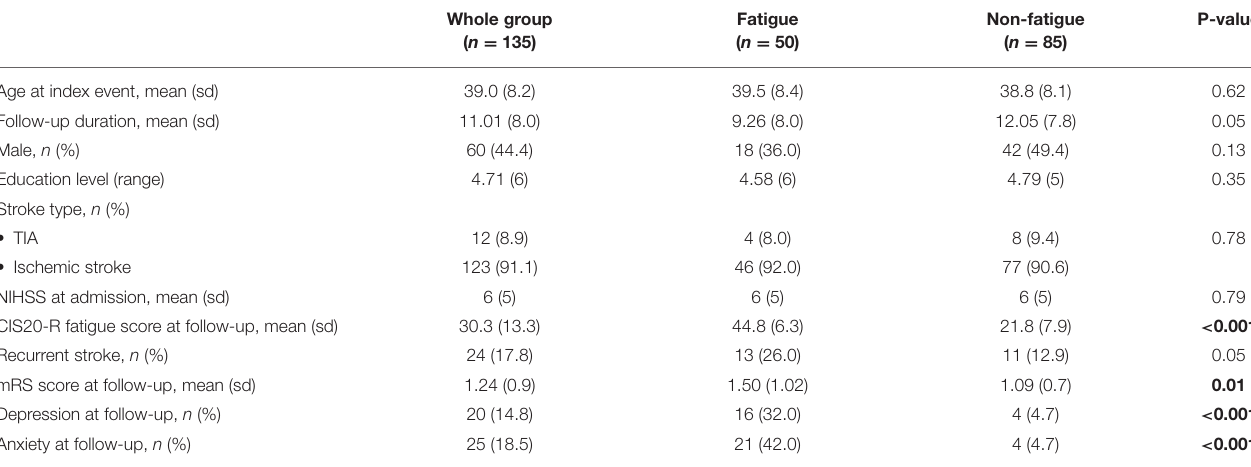
TABLE 1 | Demographic and clinical variables of fatigued and non-fatigue young stroke patients.